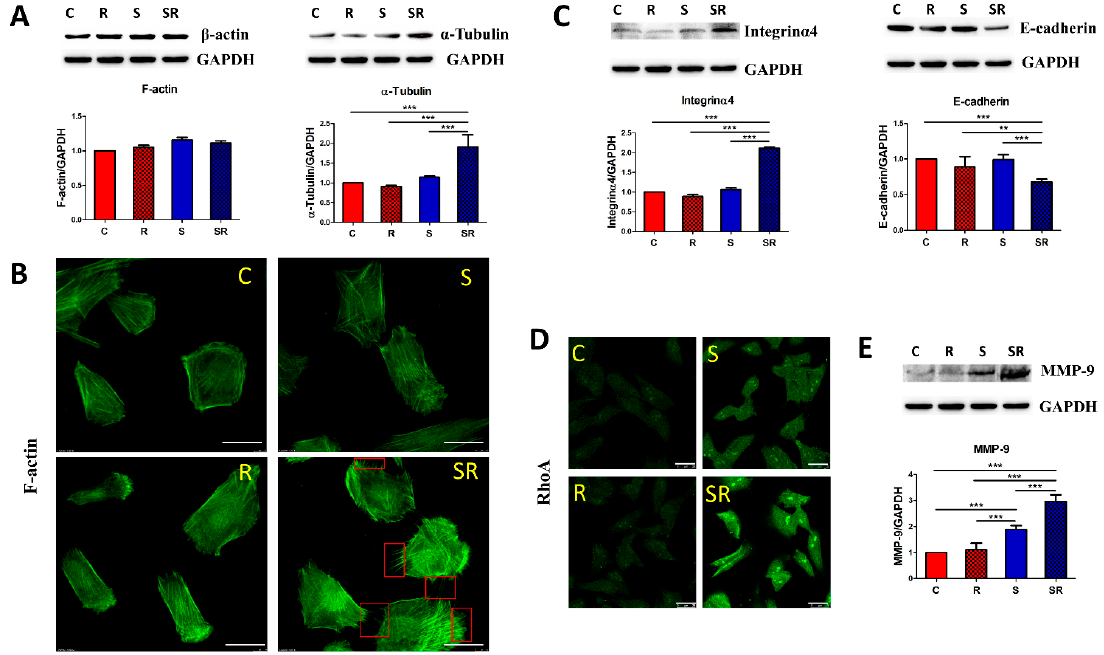
Figure 4. Protein expression of selected metastasis factors in the four different groups. ( A ) Western blot shows the F-actin and α -tubulin expression changes among the four groups; ( B ) F-actin immunofluorescence staining and filopodia counts. The red squares indicate the filopodia on irradiated-starved U251 cells. The scale bar equals 25 μ m; ( C ) Integrin α 4 and E-cadherin expression was measured by western blot; ( D ) Immunofluorescence detection of RhoA in the four cell groups. The scale bar equals 25 μ m; ( E ) Western blot shows MMP-9 expression changes among the four groups. GADPH served as loading control for western blot analyses. The data represent the means ± S.D. of three independent experiments. C, Control; R, Radiation; S, starvation; SR, starvation + radiation. ** p < 0.001, *** p < 0.0001 versus different treated groups.